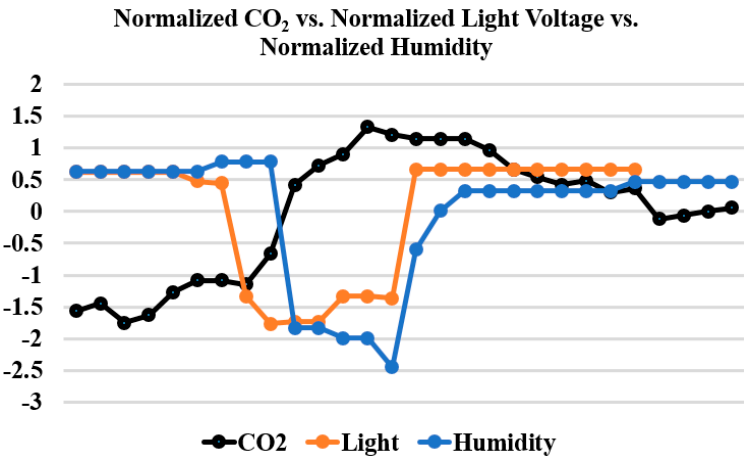
Figure 7. The recorded humidity level resultant from this fire hazard event.